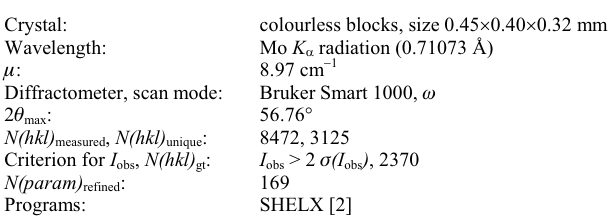
Table 1. Data collection and handling.